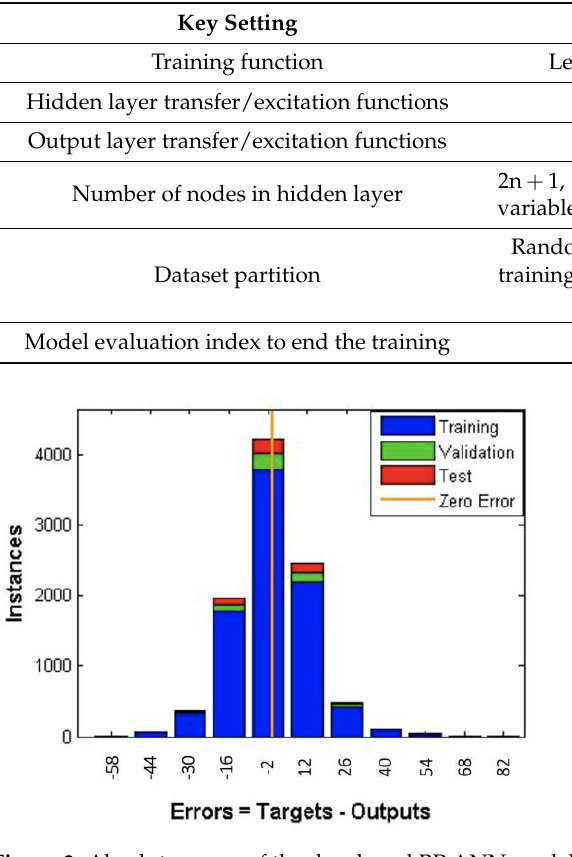
Figure 3. Absolute errors of the developed BP ANN model.